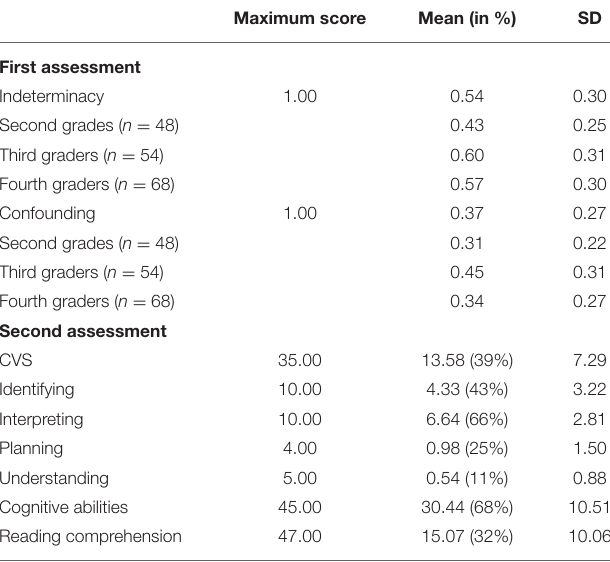
TABLE 1 | Descriptive statistics of the main study variables.